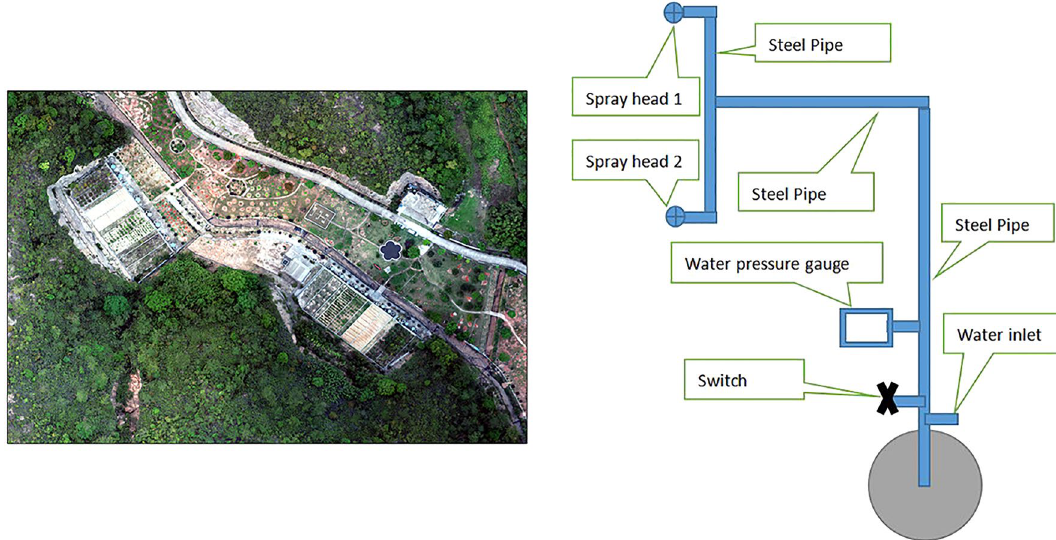
Figure 1. The experiment site and the rainfall systems.